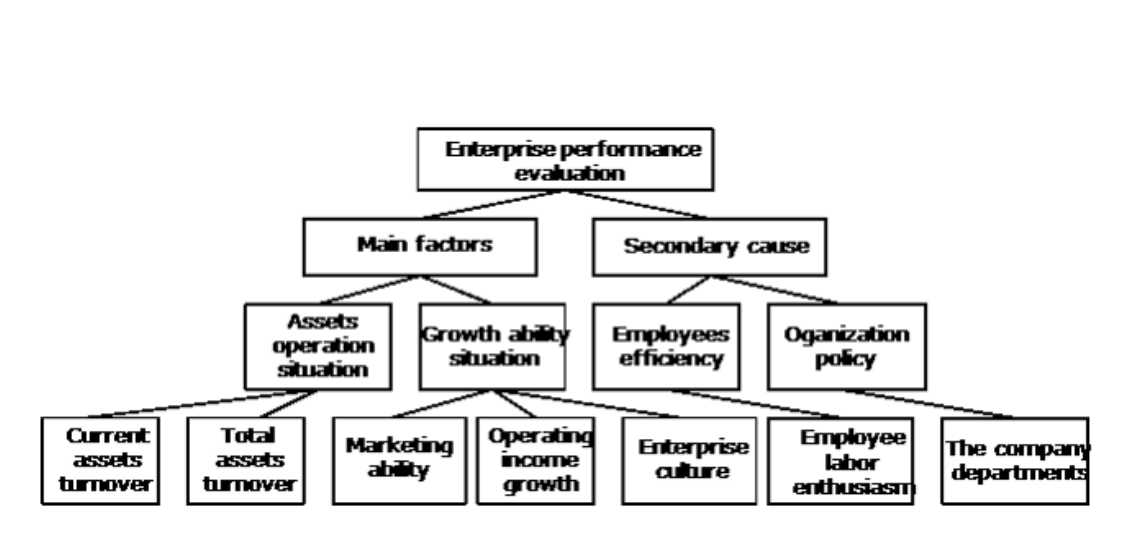
Figure 1. Index system after